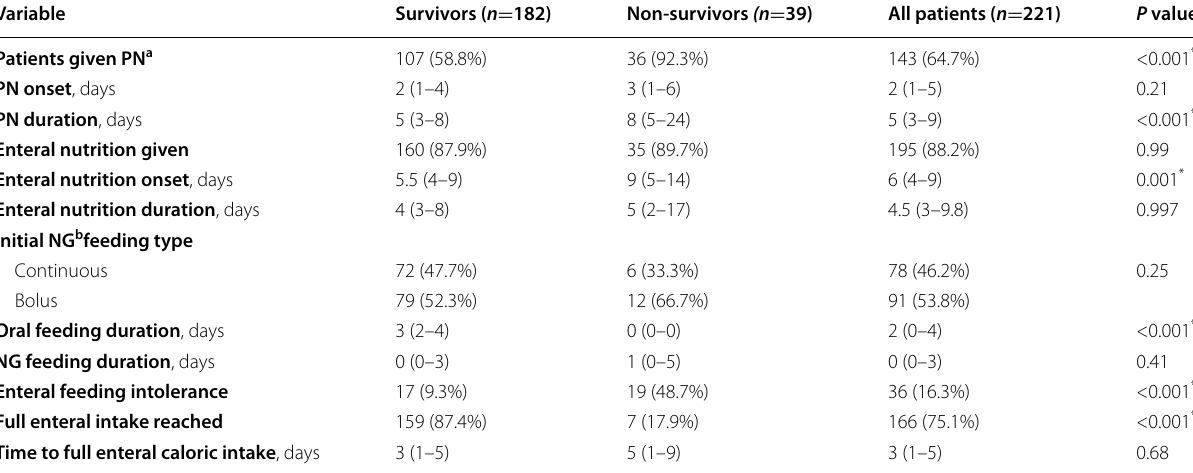
Data are expressed as median (interquartile range) or number (%) * Statistically significant a Parenteral